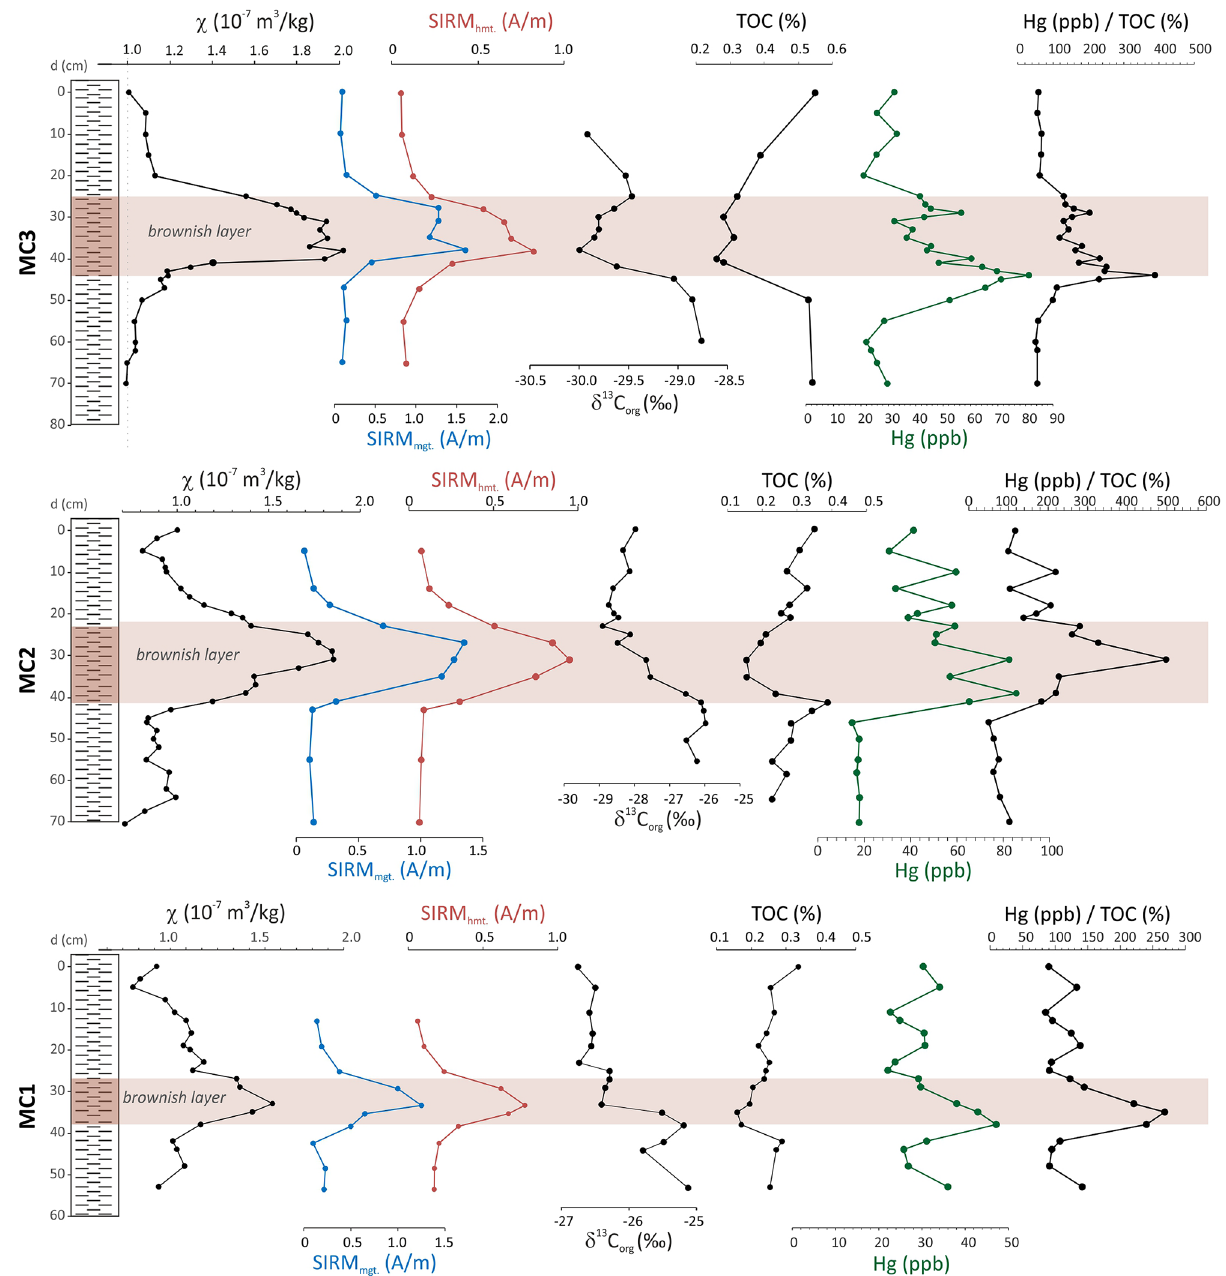
Figure 3. Three brownish layers (MC1, MC2, MC3). From left to right: Magnetic susceptibility ( χ ), saturation isothermal remanent magnetization (SIRM) of magnetite and hematite after unmixing using the Maxunmix software 97 , organic carbon isotope composition (δ 13 C org ), total organic carbon (TOC), mercury content and Hg/ TOC ratio. These distinct layers are coeval to the three rapid shifts in carbon isotope composition (shifts A – C ) illustrated in Fig. negative δ 13 C shifts within the CIE and their possible linkage to the emplacement and eruptive history of the Karoo-Ferrar LIP. Also, the age estimate of the Pl/To boundary is not well-constrained enough to definitively link it to the Karoo-Ferrar LIP. The stepwise pattern of the negative CIE and presence of distinct δ 13 C shifts have been tentatively linked to Karoo-Ferrar LIP magmatism following two model scenarios. The first scenario invokes the liberation of huge amounts of isotopically light carbon to the ocean–atmosphere system through methane hydrate dissociation controlled by astronomically forced climate variations 8,12,40 . In this model scenario, volcanogenic CO 2 from the Karoo-Ferrar magmatic events would not have effused fast enough to cause the δ 13 C shifts. Instead, magmatism would have only contributed to the slower initial ~ 2‰ decrease in δ 13 C that began before the first methane hydrate dissociation pulse inferred from the Yorkshire record 8 (Fig. 2). Global warming from volcanic outgassing